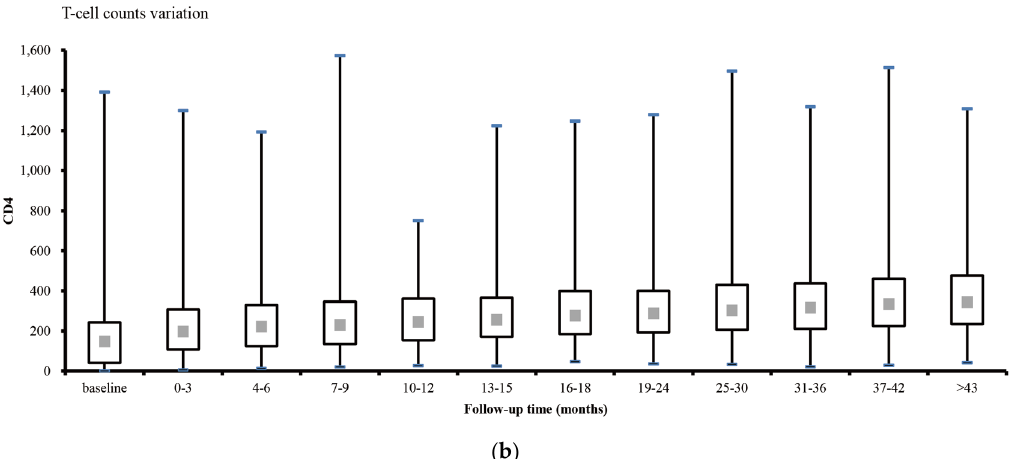
Figure A1. ( a ) Viral load variation during follow-up time after accepting ART; ( b ) CD4 T-cell counts variation during follow-up time after accepting ART. Viral load and CD4 T-cell counts variation during follow-up time after accepting ART.